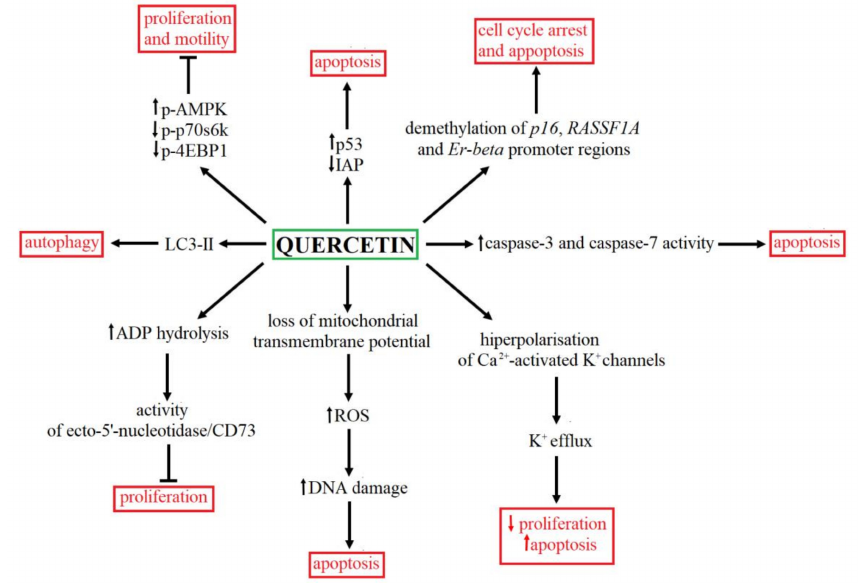
Figure 4. The summary of anticancer effects and mechanism of quercetin action. Quercetin may modulate numerous signaling pathways, including cell cycle [98] and proliferation [95,96,99], au- tophagy [97] as well as apoptosis